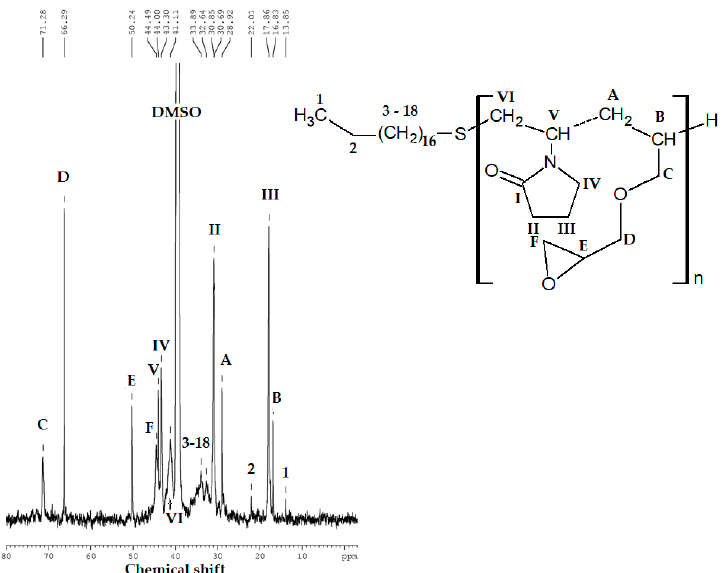
Figure 1. 13 C NMR spectrum of an amphiphilic copolymer of N -vinyl-2-pyrrolidone and allyl glycyl ether with a terminal n -octadecyl group recorded in DMSO-d6 medium.